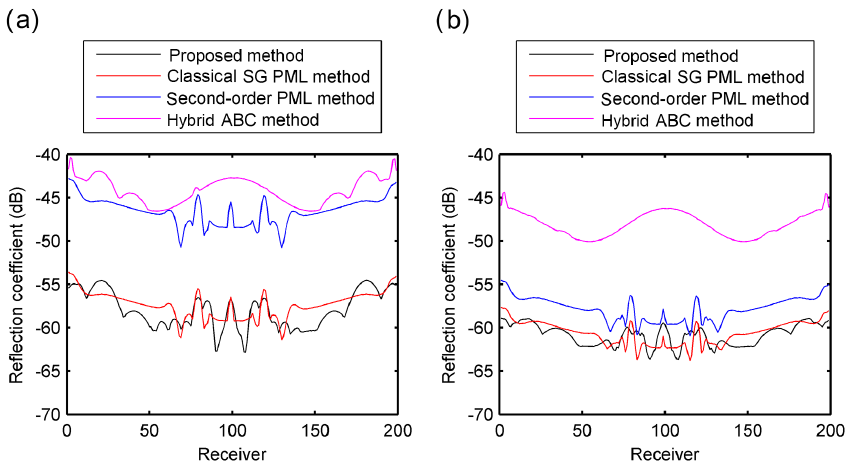
Figure 16. Values of the absorption coefficient R at each receiver for our method (red line), the classic SG PML method (black line), the second-order PML method (blue line), and the hybrid ABC method (magenta line): (a) 10 absorbing layers and (b) 20 absorbing layers.